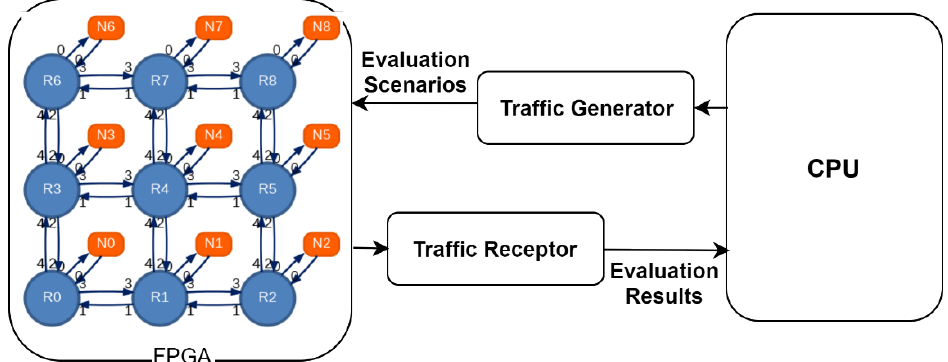
Figure 1. Generic Architecture of Networks on Chip (NoC) Evaluation on Field Programmable Gate Arrays (FPGA)(s) .